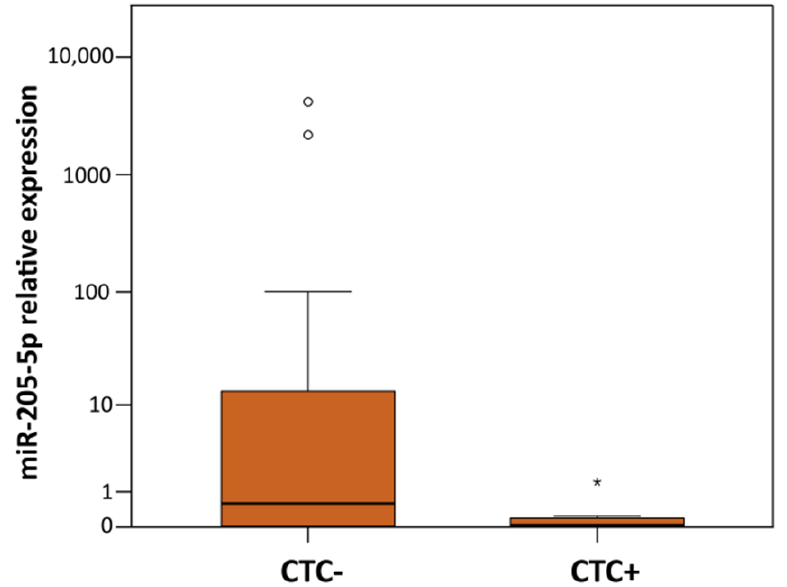
Figure 4. Individual expression levels of miR-205-5p in CD45-depleted peripheral blood of CTC negative (CTC-) and positive (CTC+) BC patients. The median is depicted by a horizontal line within each bar. The length of the boxes is the interquartile range (IQR) that represents values between the 75th and 25th percentiles of individual fold change values. Values more than 3 IQRs from the end of the box are labeled as extreme (*). Values more than 1.5 IQRs but less than 3 IQRs from the end of the box are labeled as outliers (O). Abbreviations: BC, breast cancer; CTC, circulating tumor cells.